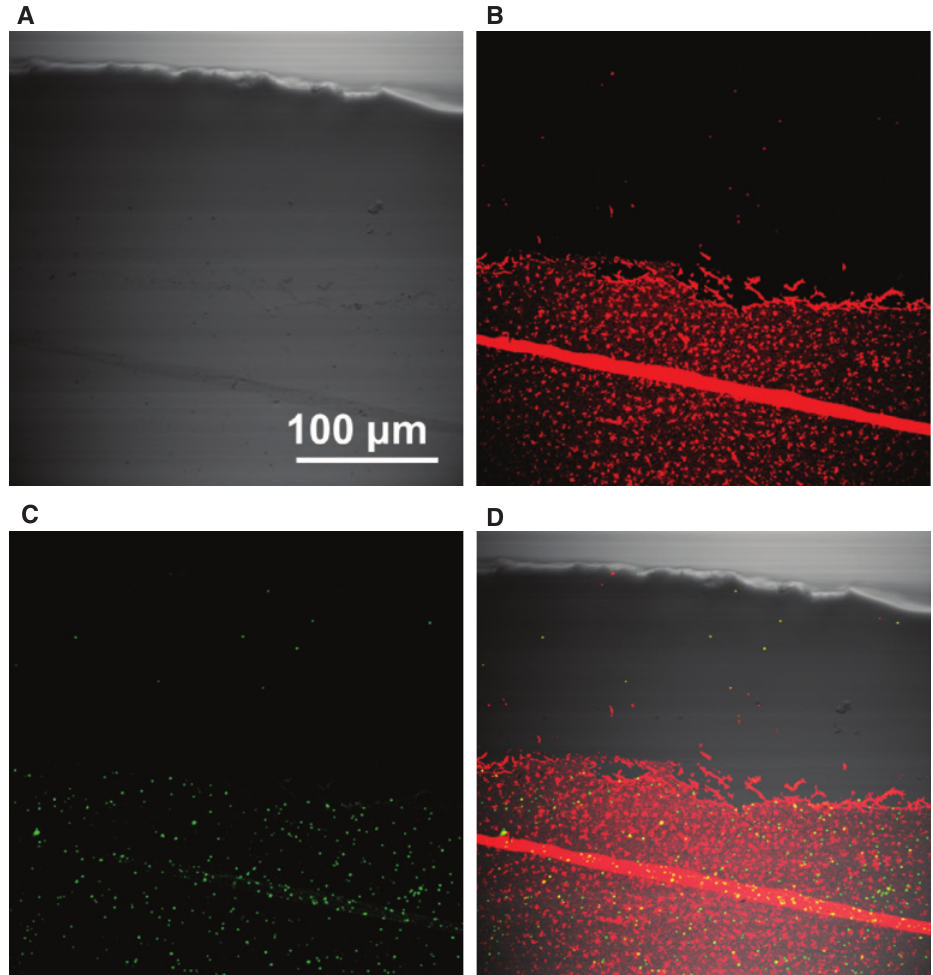
Figure 8: (A) Bright field of monolayer graphene. (B) CARS image of graphene. (C) TPEF + SHG image of graphene. (D) The merged image of bright field + CARS + TPEF + SHG at Raman mode 1360 cm −1